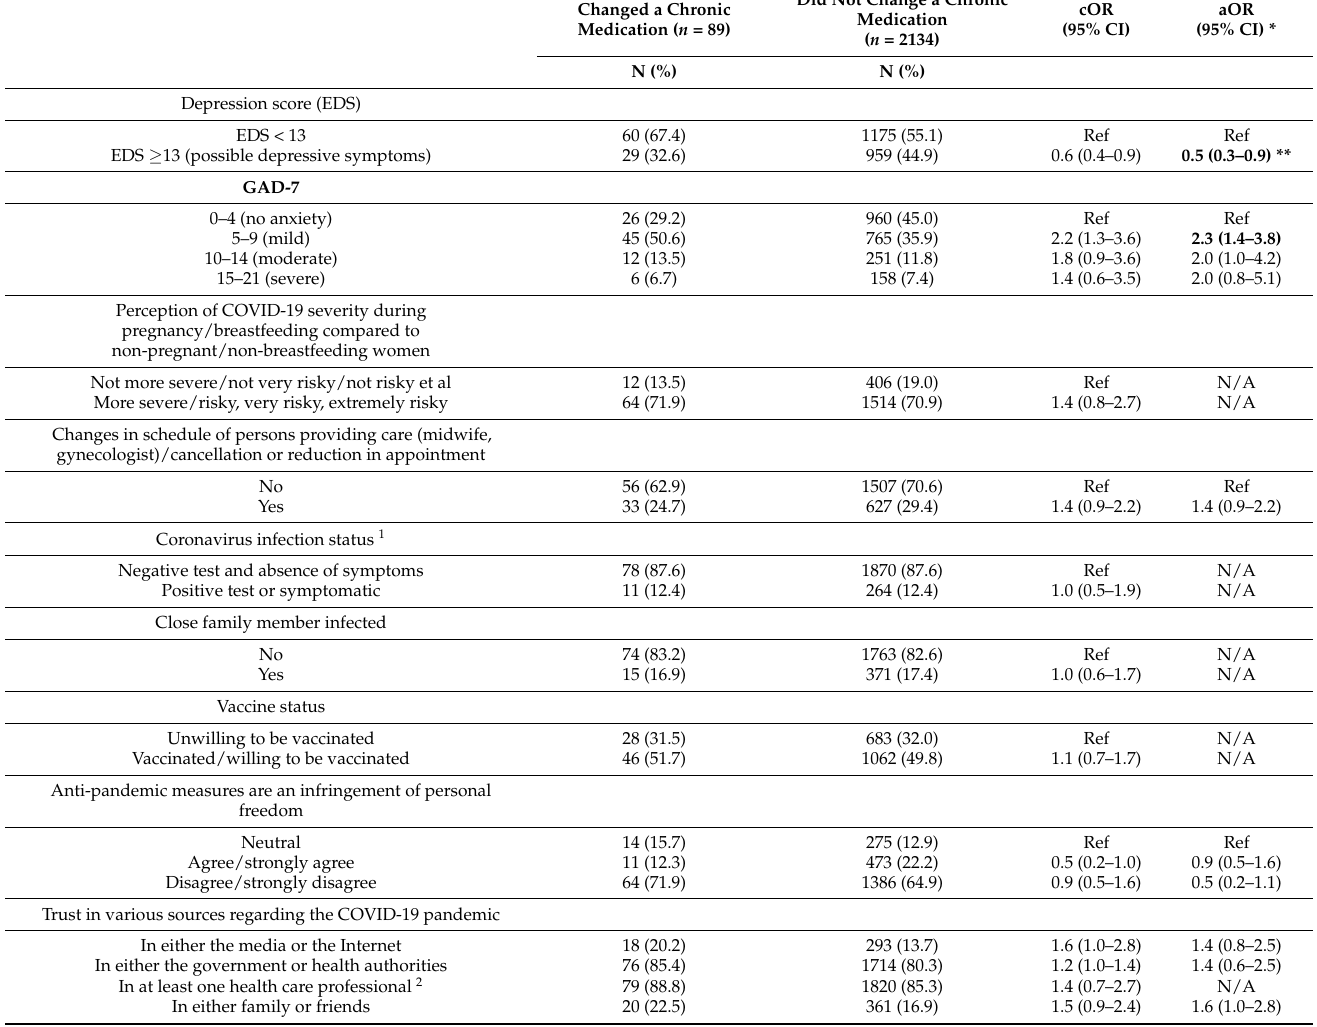
Table 4. Factors associated with changes in the use of a chronic medication due to COVID-19 among chronic medication